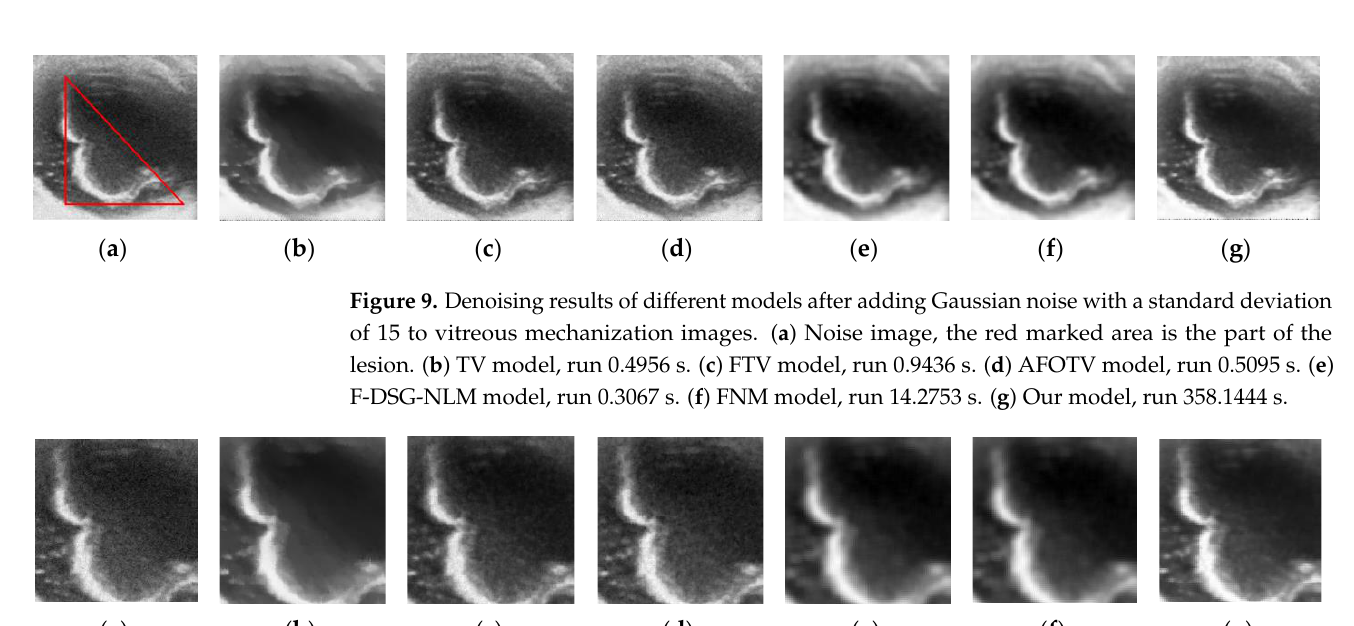
Figure 8. Magnified image of vitreous hemorrhage in part of the lesion. ( a ) Noise image. ( b ) TV